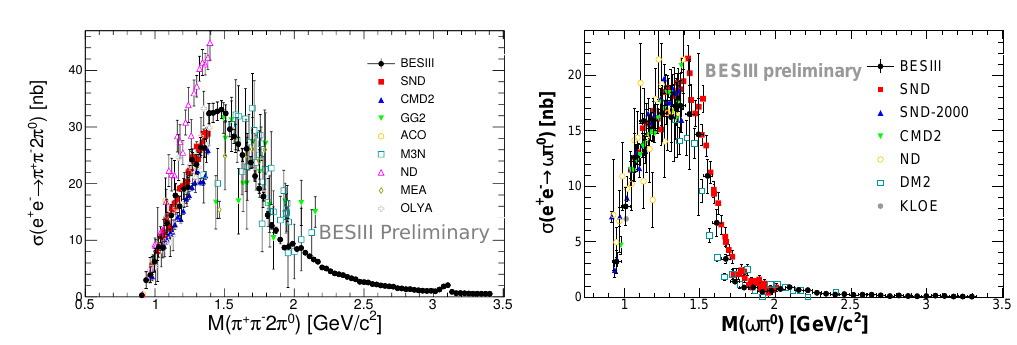
Figure 4. π + π − 2 π 0 cross section (left) and ωπ 0 cross section (right).